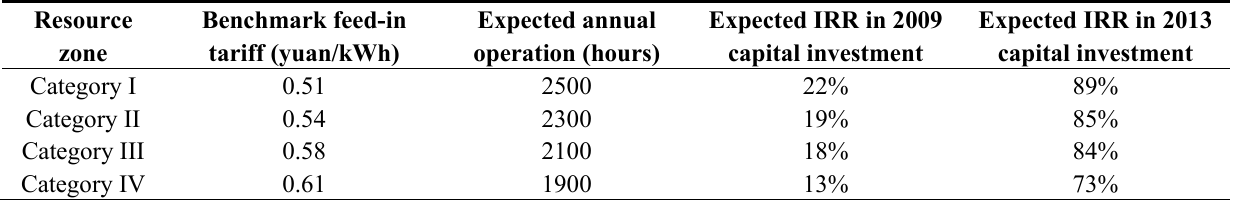
Table 7. Estimated IRRs of wind power under the existing FIT policy, 2009 and 2013